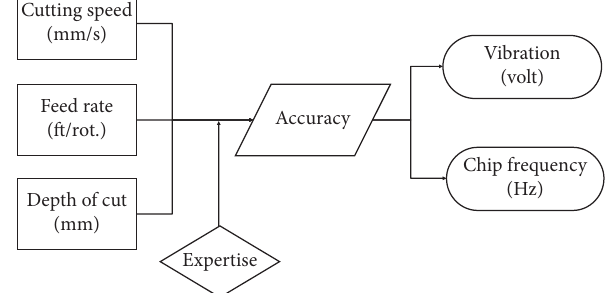
Figure 6: The relationship between the